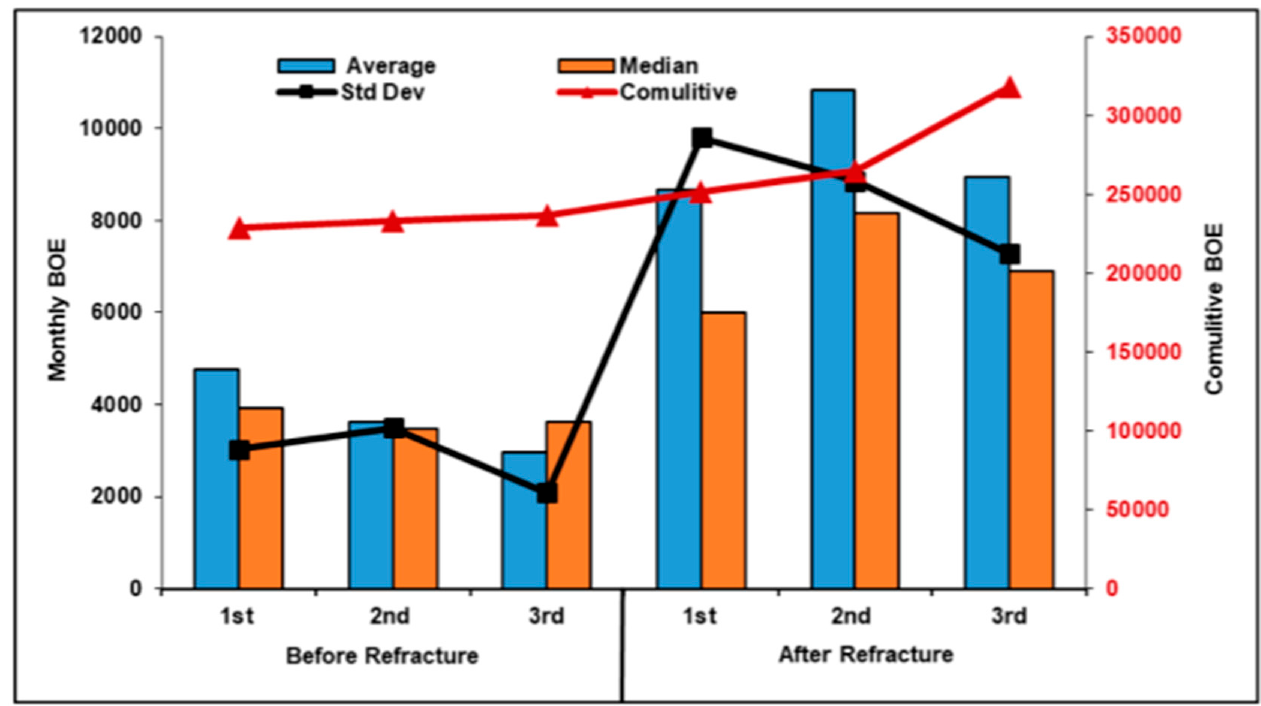
Figure 1. Expected production gains in Bakken after re ‐ fracturing treatment [3].